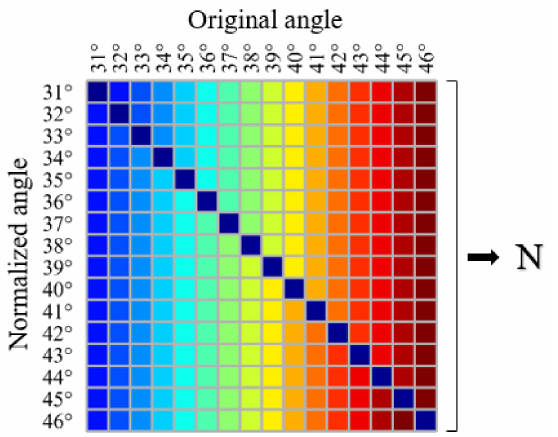
Figure 4. The combination of normalized angle for least squares